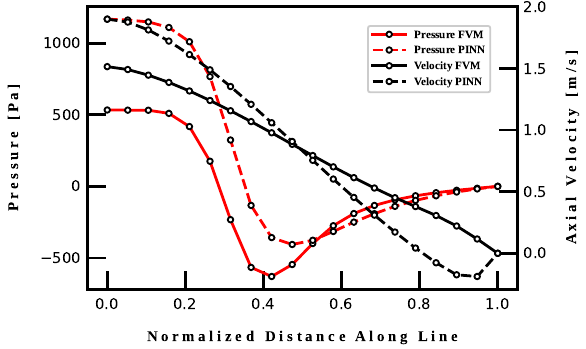
Figure 13. Section plot for the turbulent solution at a valve angle of 45 ◦ ; the pressure profile along the symmetry plane is in red, and the axial velocity profile downstream of the valve is in